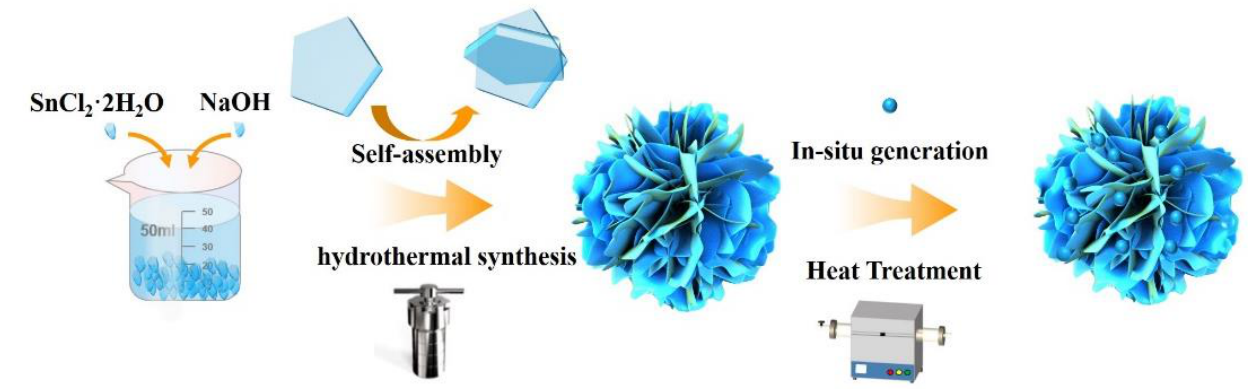
Figure 2. Schematic diagram of the preparation of flower-like Sn/SnO 2 composites.